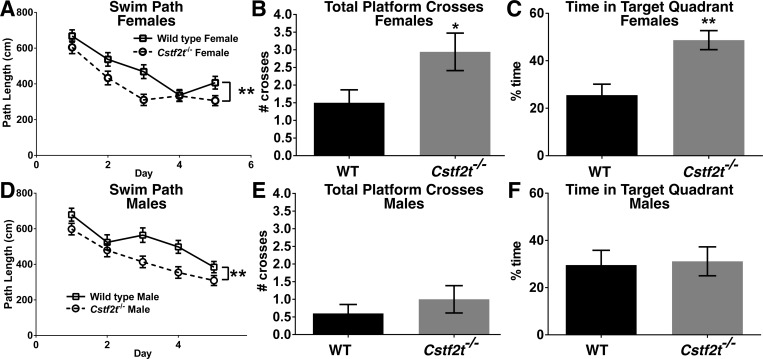
Both male and female mice show differences in average swim distances between wild type and Cstf2t-/- mice, while female Cstf2t-/- mice display significantly better reference memory 24 hours after Morris water maze training.Female and male Cstf2t-/- and wild type mice were trained to find a submerged platform in a Morris water maze (MWM) four times per day for 5 days followed by reference memory trials 24 hours post training, during which the platform was removed. (A and D) Distance swam (in cm) to reach the escape platform between wild type and Cstf2t-/-
(A) female and (D) male mice was examined using a 2-way ANOVA (F (3, 1340) = 13.16; p = 0.0001), indicating significant group differences. A post-hoc Tukey’s multiple comparison test indicated significant differences between both female and male wild type and Cstf2t-/- mice (**p<0.001). (B and E) Total number of platform crosses (how many times a mouse swam over the escape platform’s previous location) 24 hours after the last training day. (B) Female Cstf2t-/- mice showed a significantly greater number of platform crosses than female wild type mice using a two-tailed Student’s t-test (p<0.05). (E) There was no significant difference in total number of platform crosses between wild type and Cstf2t-/- male mice (Student’s t-test). (C and F) Percent of time spent in the target quadrant (how much of the reference trial period the mouse spent in the maze quadrant where the escape platform used to reside). (C) Female Cstf2t-/- mice showed a significantly greater amount of time in the target quadrant than female wild type mice (two-tailed Student’s t-test, p<0.001). (F) There was no significant difference in total number of platform crosses between male wild type and male Cstf2t-/- mice (Student’s t-test)). All data are presented as mean ± SEM. *p<0.05, **p<0.001. ANOVA analyses were conducted using all groups.